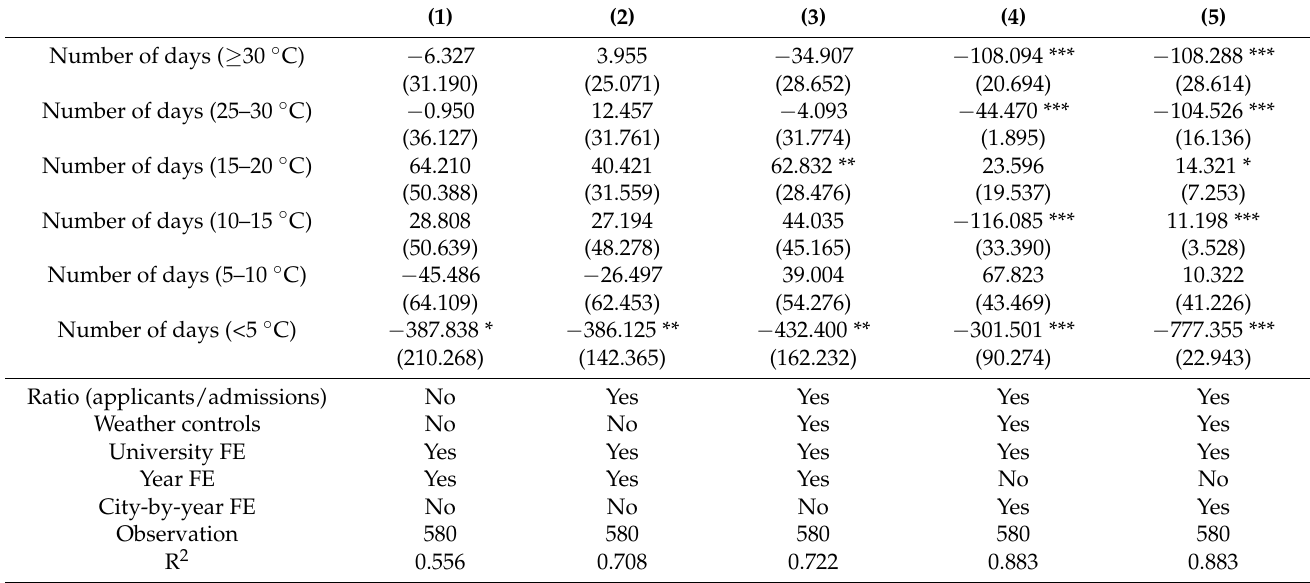
Table 2. Effects of average temperature on the number of applicants.